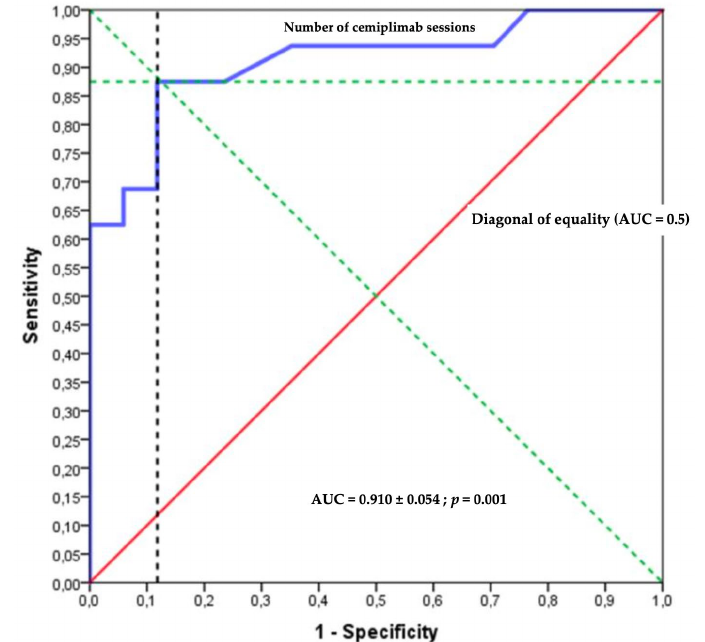
Figure 3. Receiver operating characteristic (ROC) curve.